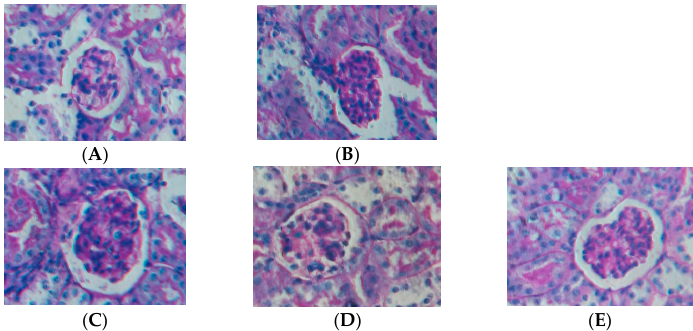
Figure 1. Effect of Hedyotis diffusa extract in the LPS-treated mice: histological appearance of renal sections of mice treated with saline ( A ); LPS ( B ); low dose (1.25 g/kg body weight) ( C ); medium dose (2.5 g/kg bw) ( D ); and high dose (5.0 g/kg bw) ( E ) of water extract of H. diffusa . The renal sections were analyzed by PAS staining (magnification is 400×).